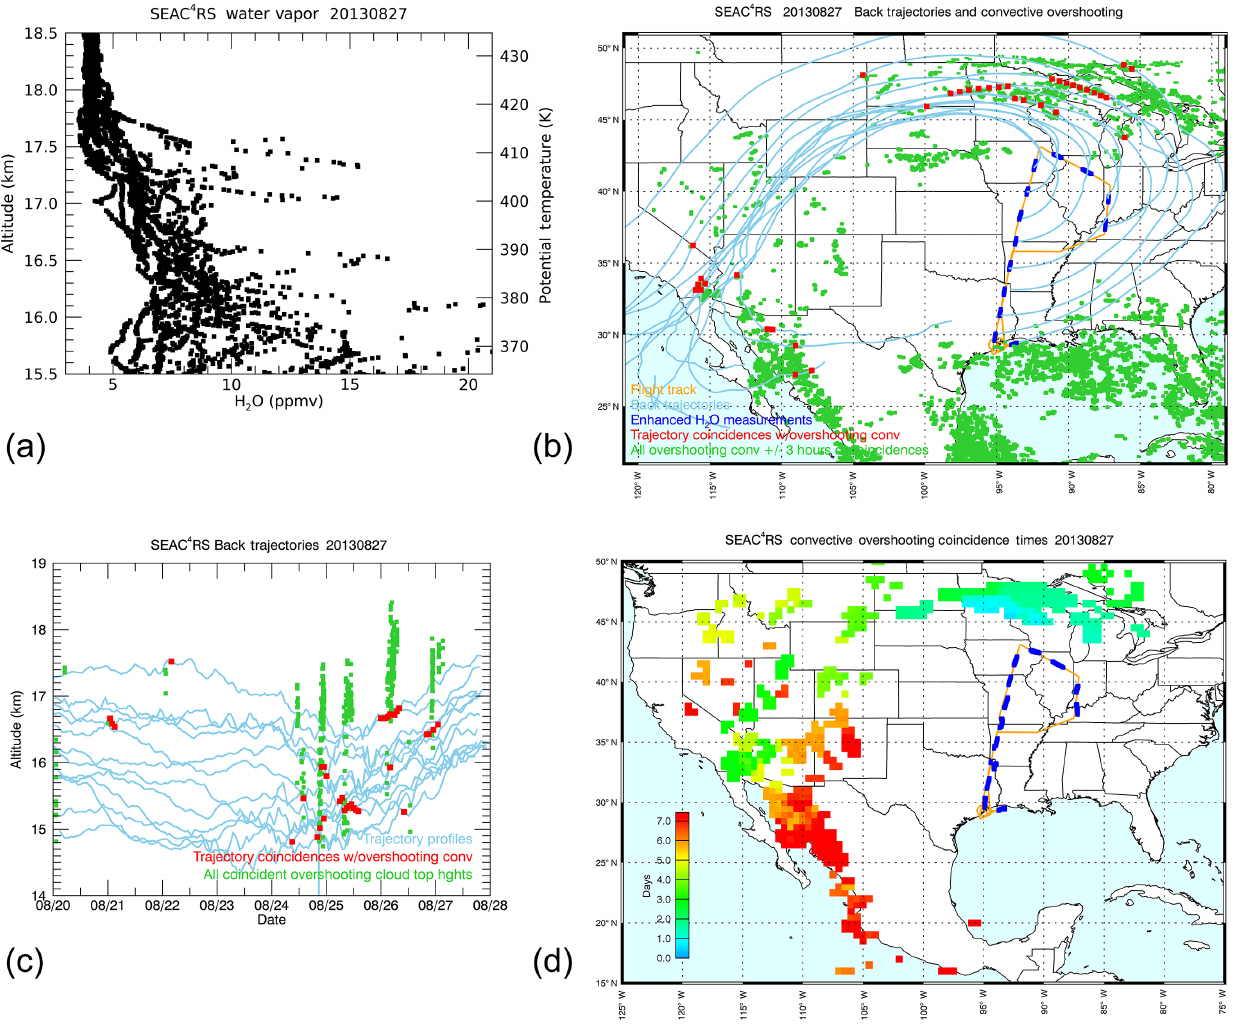
Figure 8. An analysis of the 27 August 2013 NASA ER-2 flight. (a) Vertical profiles of JLH Mark2 in situ H 2 O; similar to Fig. 6a. (b) Back trajectories from the aircraft path; similar to Fig. 6b. (c) Altitude plot of back trajectories showing coincident overshooting (red) and all overshooting within ± 3h (green); similar to Fig. 6c. (d) Days between OT and intercept by the aircraft; similar to Fig.